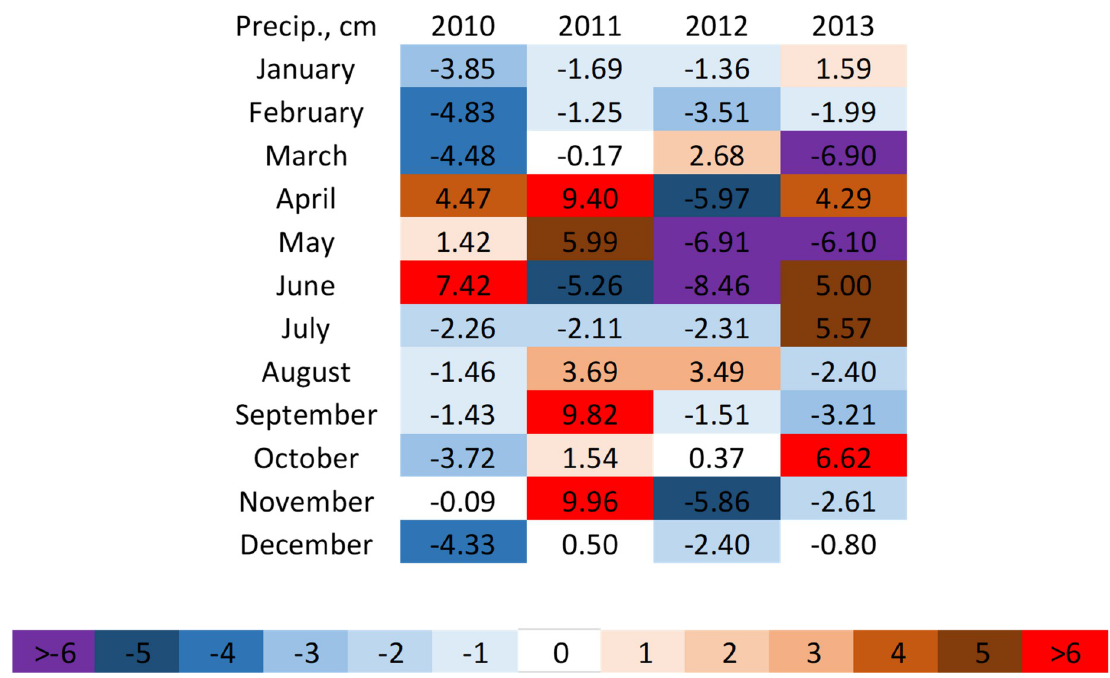
Fig 4. Monthly precipitation anomalies ( P ,) in modern observation years (2010–2013) relative to historic average monthly total Aix precipitation ( P i , hist , 1883–1912, cm). Positive or negative anomalies indicate that a given month received more or less precipitation than in the historic period,